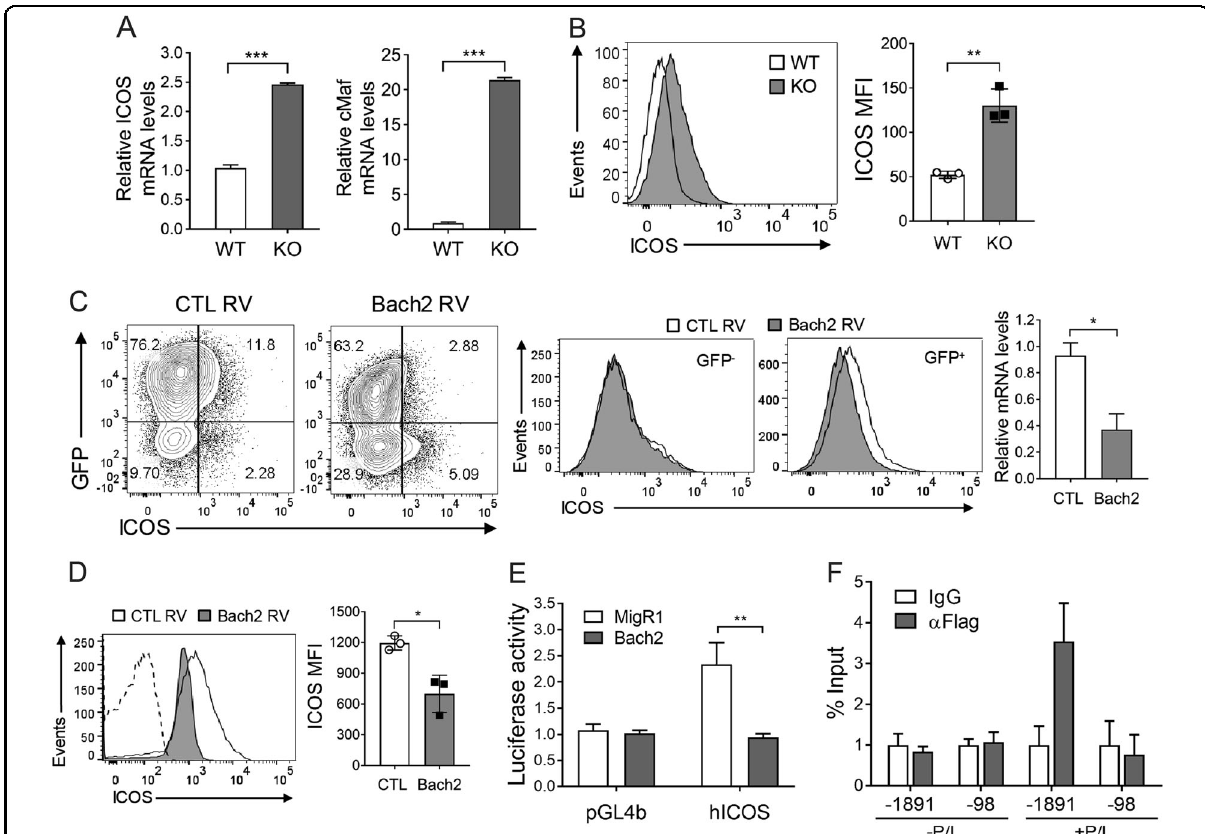
Fig. 6 Bach2 represses Icos transcription. a , b Splenic CD4 + T cells from Bach2 KO and WT mice were assayed by quantitative RT-PCR a and FACS b . c , d CD4 + T cells infected with either a Bach2- or an empty vector-expressing retrovirus (RV) were assayed by FACS and RT-PCR c and transferred to Tcr β − / − mice, followed by FACS analysis 10 days later d . FACS pro fi les gated on CD4 + cells are shown. e Jurkat T cells were cotransfected with a pGL4b-hICOS reporter and a MigR1 – Bach2 or an empty vector, stimulated with PMA and ionomycin, and assessed by a luciferase activity assay. f Jurkat T cells were transfected with the pcDNA3-2 × FLAG-Bach2 vector, incubated in the presence or absence of PMA and ionomycin (P/I), and assayed by ChIP-qPCR. All data are representative of three independent experiments. * p < 0.05, ** p < 0.01 and *** p < 0.001 by Student ’ s t